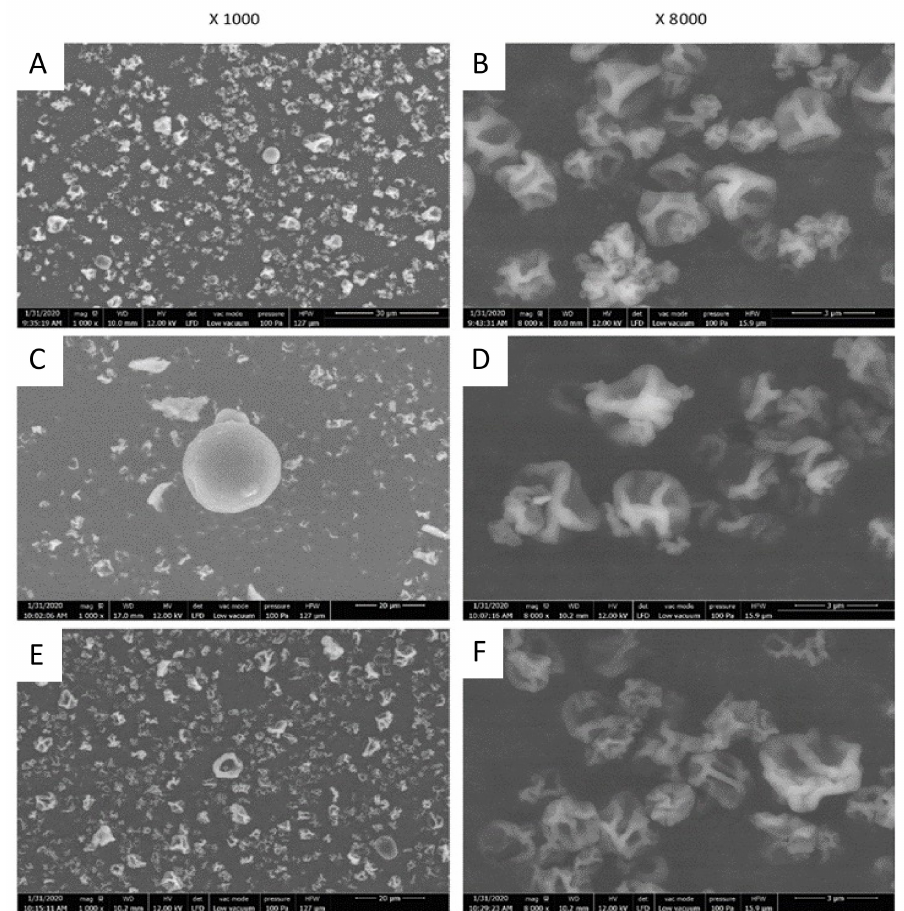
Figure 2. Microparticle analysis by SEM. Observations with a Scanning Electron Microscope of the microparticles obtained after MAE encapsulation in the three wall materials. ( A , B ) Maltodextrin microparticles with MAE, ( C , D ) soy protein microparticles with MAE, ( E , F ) starch microparticles with